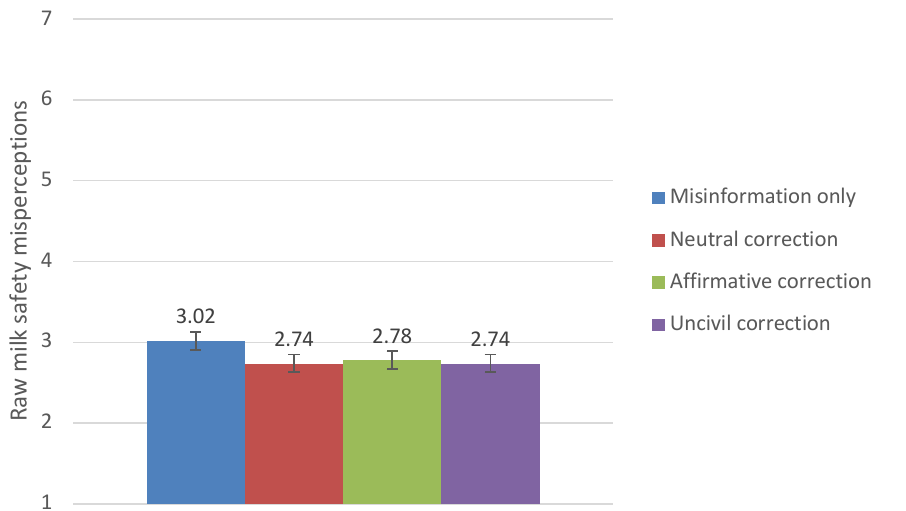
Figure 2. Misperceptions about the Safety of Raw Milk by Experimental Condition. Note that higher numbers reflect less accurate attitudes towards the safety of raw milk. Each color shows the average for the group. Error bars represent a 95% confidence interval for the results.